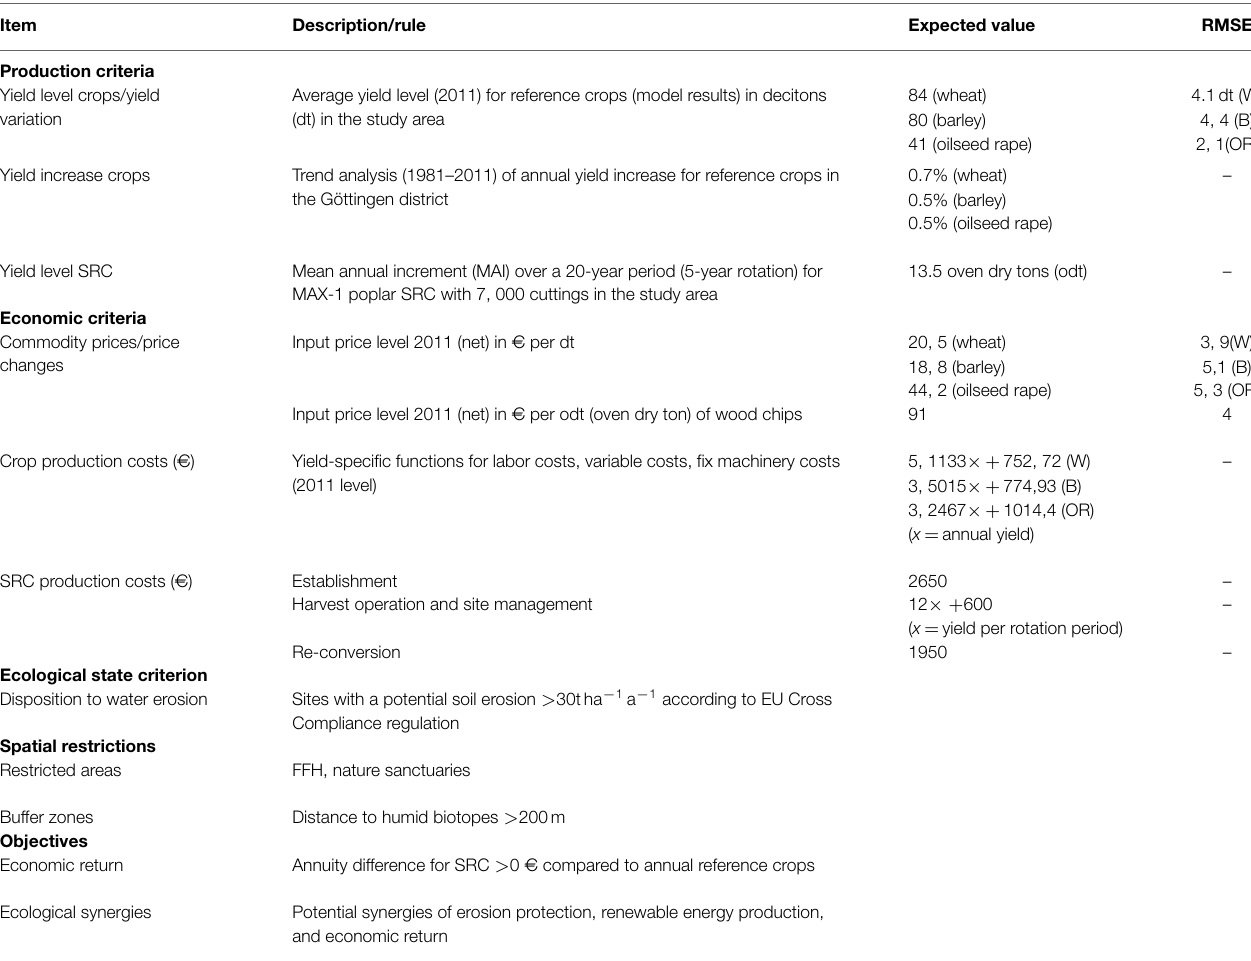
TABLE 1 | Scenario setting for the BEAST assessment in the municipality of Friedland